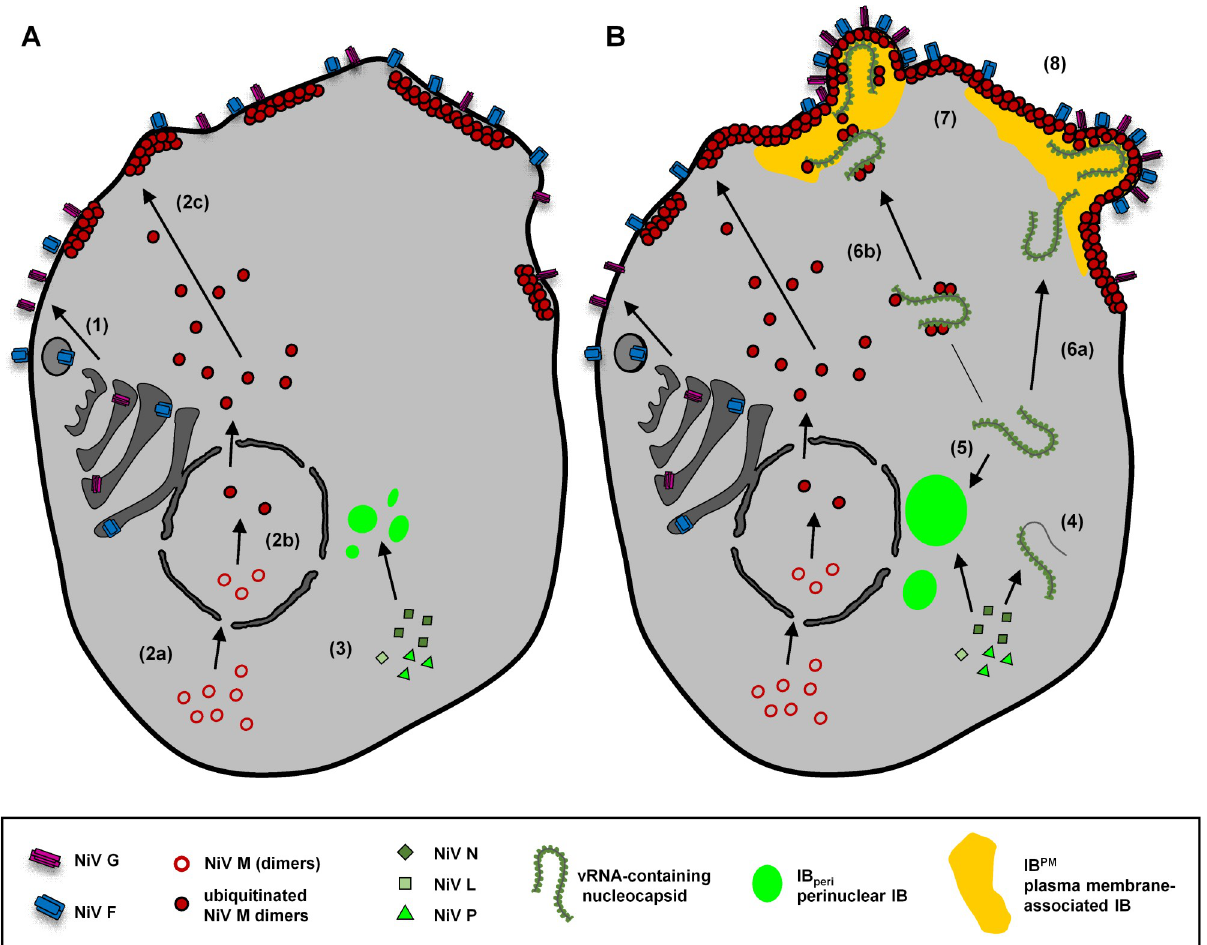
Fig 9. Model for IB formation and assembly during NiV infection. (A) NiV protein synthesis and trafficking in early infection stages. NiV surface glycoprotein F and G are synthesized in the ER and transported to the plasma membrane via the secretory pathway (1) . NiV M is synthesized in the cytoplasm and rapidly imported into the nucleus (2a) . Only after monoubiquitination at K258, NiV M can exit the nucleus (2b) . After nuclear transit, NiV M traffics to the plasma membrane to form a dense matrix underneath the plasma membrane (2c) . NiV N, P, and L proteins are synthesized at ribosomes throughout the cytoplasm and concentrate rapidly in perinuclear IBs (3) . (B) IB formation and assembly in late infection stages. NiV replication and transcription is assumed to occur in cytoplasmic reticular structures rather than in IBs. Newly synthesized viral genomes are encapsidated by the viral nucleocapsid proteins to form NCs (4). NCs are recruited to IB peri until sufficient M protein is expressed (5) . NC are transported to the cell periphery either independently (6a) or via cotransport with M proteins (6b) . NCs and M proteins accumulate at the plasma membrane and form IB PM (7) . The NiV glycoproteins are clustered at IB PM sites and virus budding is initiated (8) . Please refer to the text for a more detailed discussion of the model.